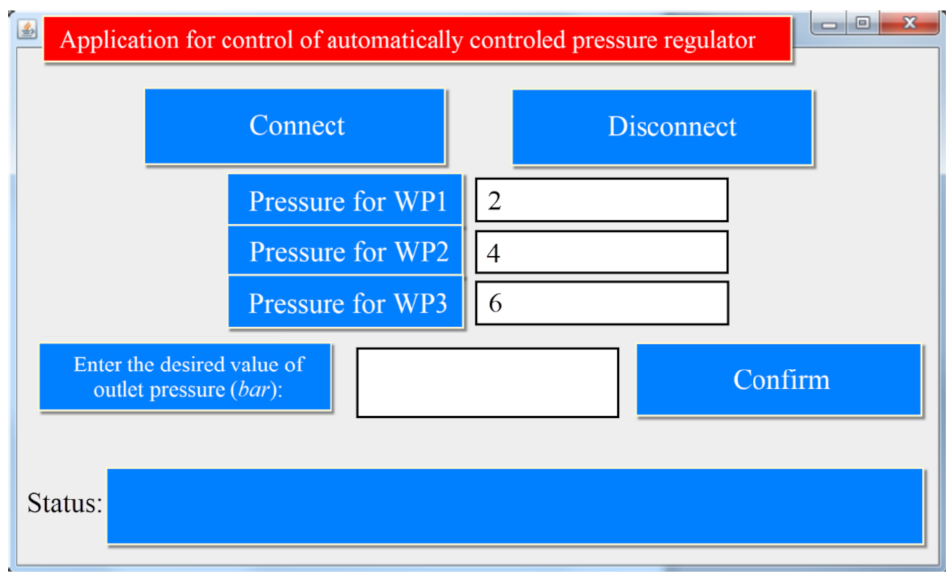
Figure 8. Pressure control